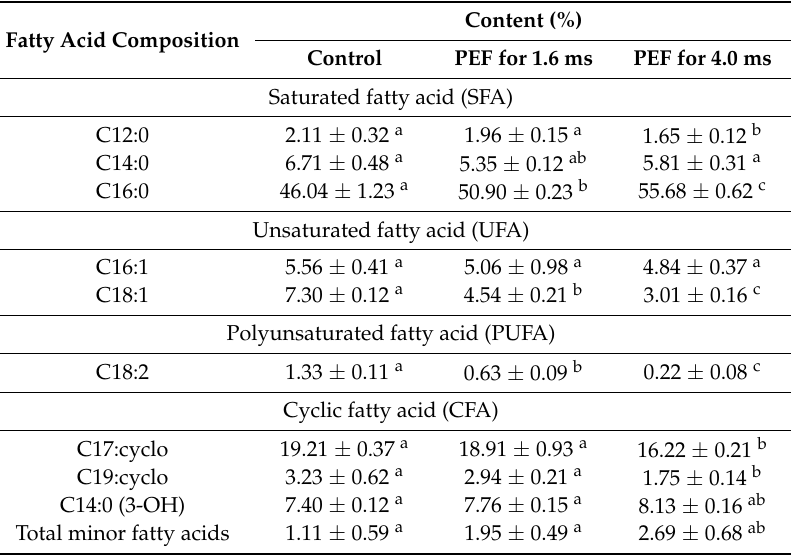
Table 1. Fatty acids composition of stationary phase cells of Salmonella typhimurium ( S. typhimuriumi ) before and after pulsed electric field (PEF) treatment at 25 kV/cm.